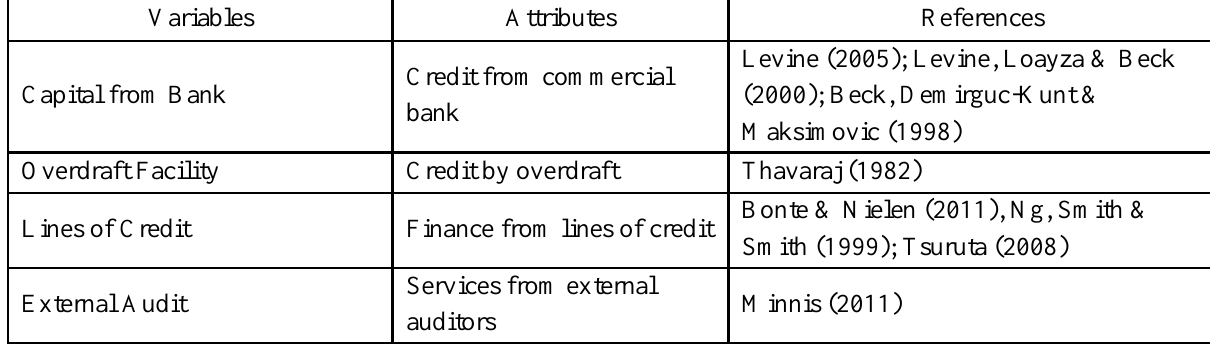
Table 1. Variables, attributes, and